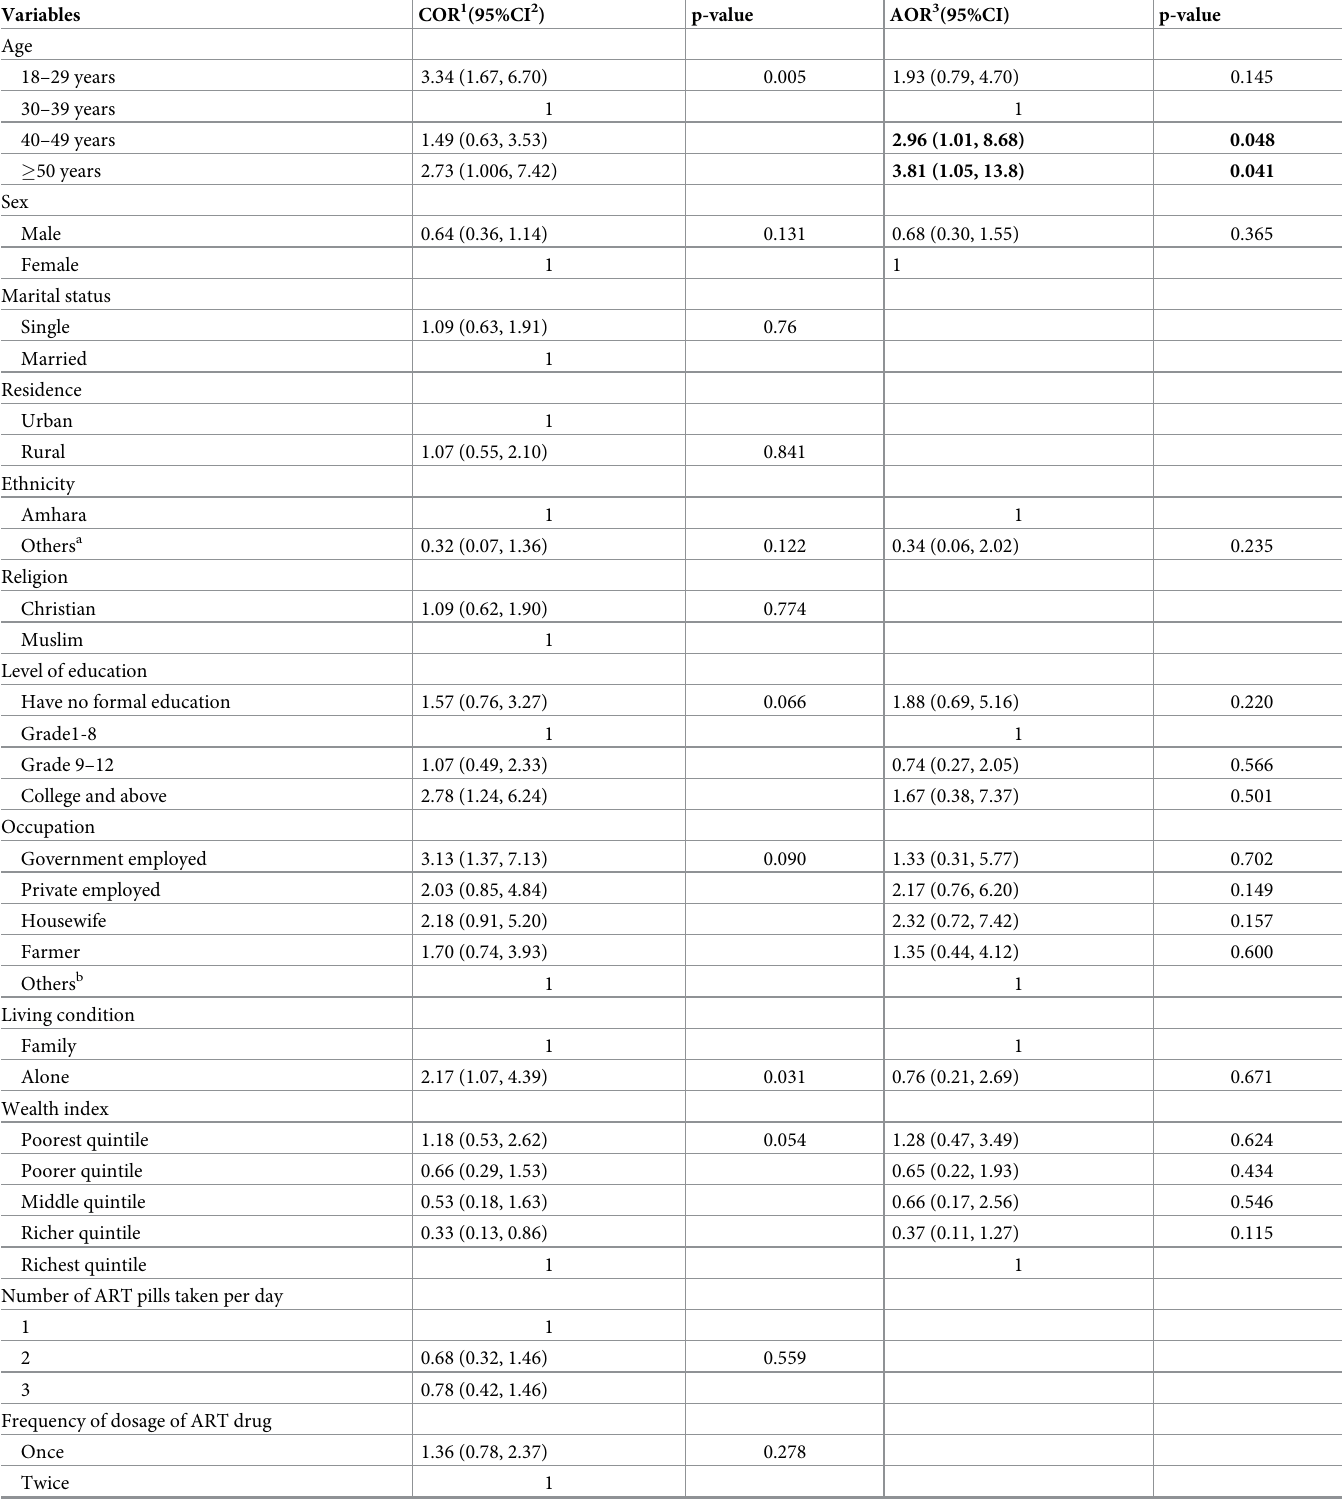
Table 3. Factors associated with depressive symptoms among HIV positive patients attending public health facilities of Dessie town, Northeast Ethiopia,